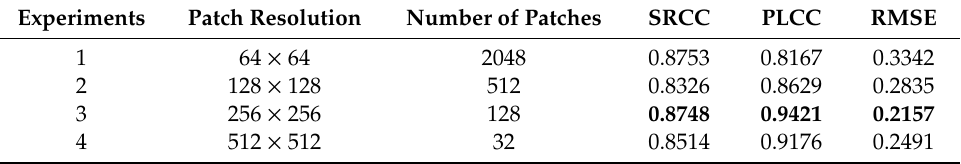
Table 4. Performance comparison of our proposed method across di ff erent patch